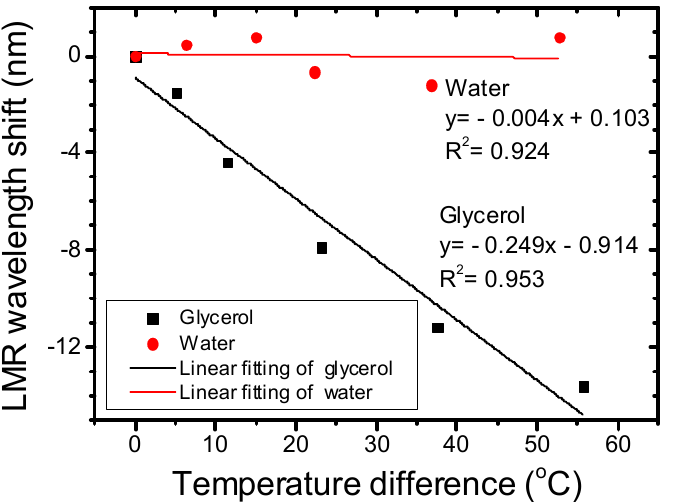
Figure 7. Shift in the LMR wavelength for water and glycerol as a function of temperature difference, where the red circles and the black squares represent the respective experimental data of water and glycerol.